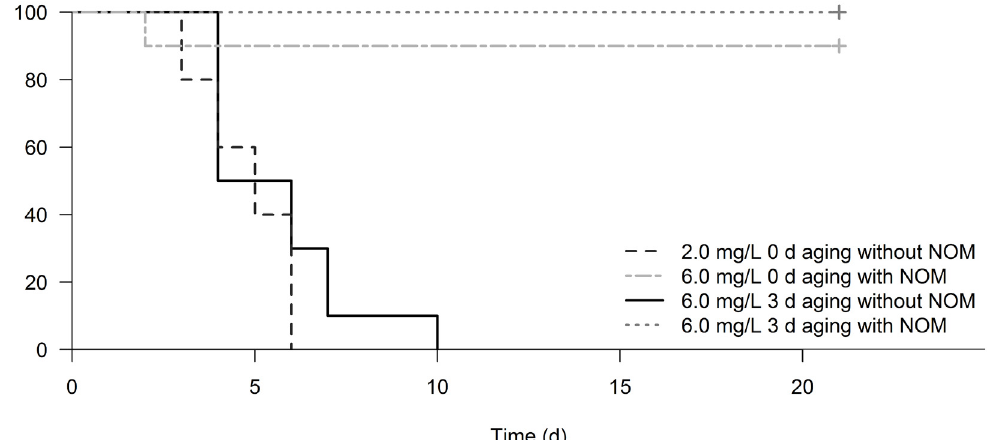
Fig 2. Survival time analysis during chronic exposure. Survival (%) of daphnids during the 21 d chronic toxicity tests with nTiO 2 . Lines represent the exposure to nTiO 2 (i.e. 2.0 or 6.0 mg/L) aged under varying conditions (0 or 3 d) in ASTM with and without NOM.